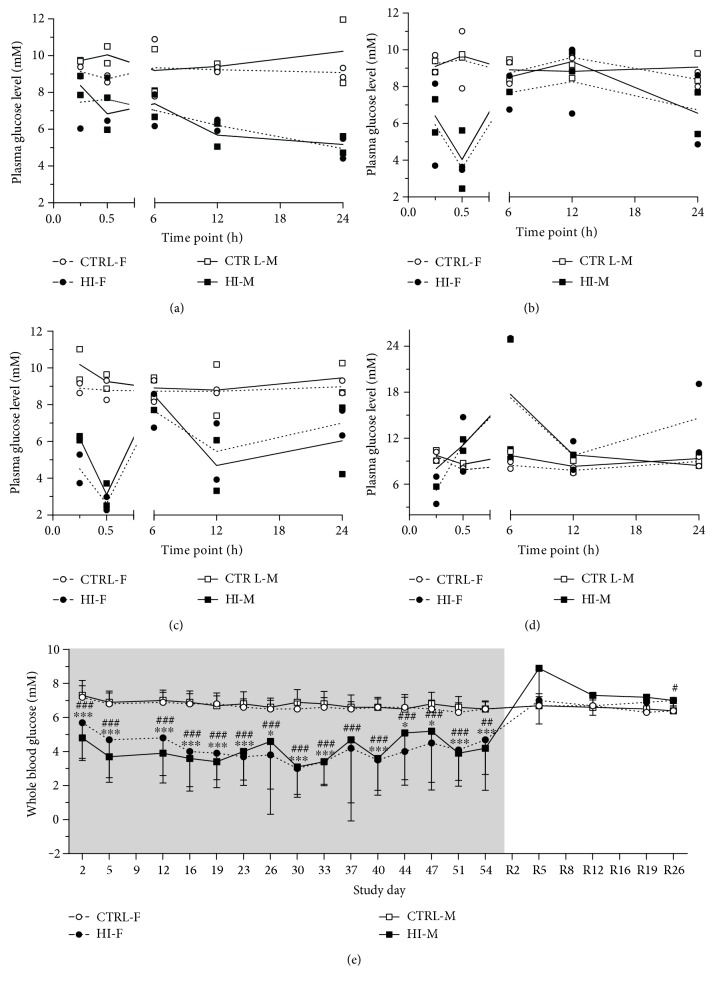
Blood glucose levels. Plasma profile Day 1 (a), Day 25 (b), Day 53 (c), and Day R1 (d). Individual (symbols) and mean (lines) values, n = 1 − 2/time point. Infusion start was defined as time point zero on day 1. Time point zero on day R1 corresponds to the time point when infusion was stopped. (e) Whole blood mean values + SD. Grey area indicates infusion period. During infusion: days 2–23: n = 28 − 38/group per time point, days 26–51: n = 22 − 28/group per time point, and day 54: n = 12 − 17/group per time point. During infusion-free period (recovery): n = 5 − 10/group per time point. ∗p < 0.05, ∗∗p < 0.01, and ∗∗∗p < 0.001 for HI-M versus CTRL-M; #p < 0.05, ##p < 0.01, and ###p < 0.001 for HI-F versus CTRL-F. Levels in the HI-M and HI-F groups were only significantly different on two time points: day 5 (p < 0.05) and day R12 (p < 0.05).